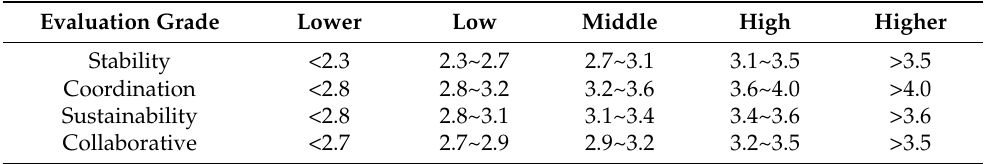
Table 4. System security